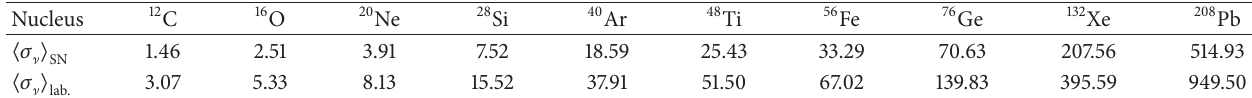
∼ 10 7 ] s −1 cm − 2 at 20m for all nuclear targets. 𝛼